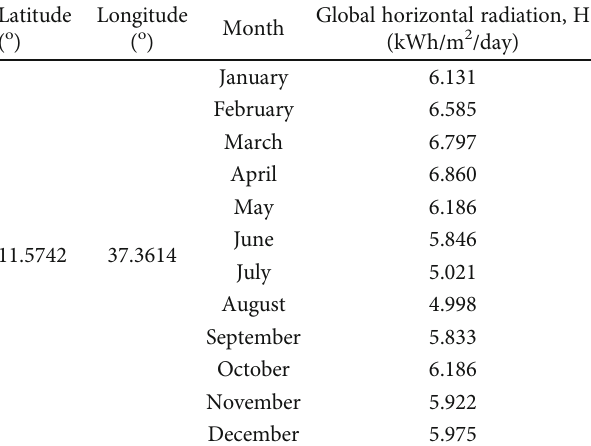
Table 2: Geographical coordinates and monthly average daily global horizontal radiation data of Bahir Dar